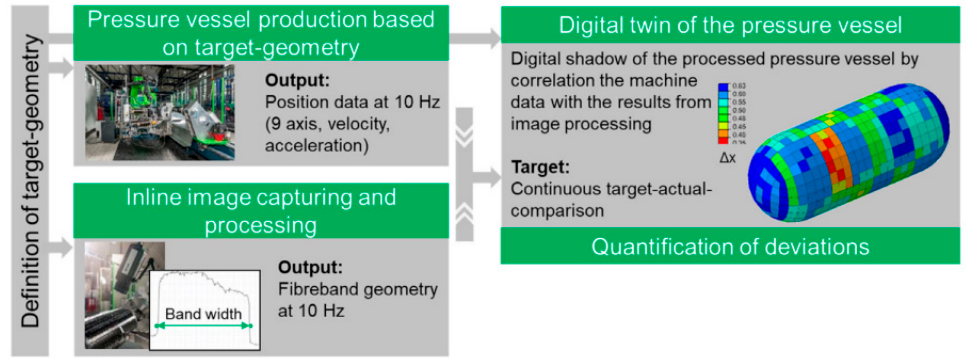
Figure 36. Digital twin during manufacturing of Type IV pressure vessels for design optimization [135].